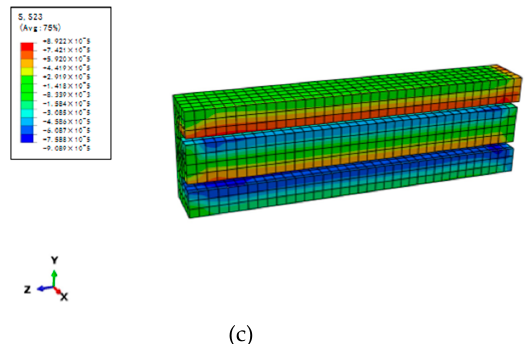
Figure 16. The cutting stress nephograms of RAC at different directions along the section steel: ( a ) the lower flange; ( b ) the upper flange; ( c ) the web.